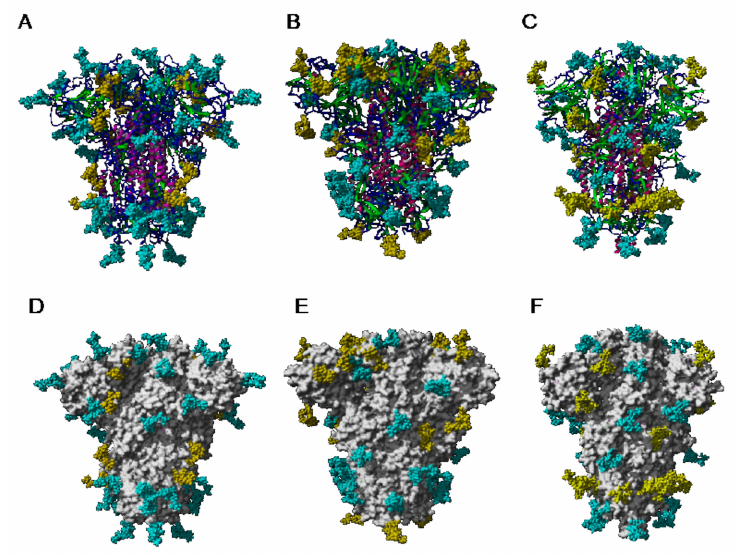
Figure 28. ( A – C ). Lateral face of the ribbon diagram representing the homotrimeric spike of SARS-CoV (PDB code 6ACD) ( A ), MERS-CoV (PDB code 5W9H) ( B ), and SARS-CoV-2 (PDB code 6VXX) ( C ). High- mannose glycans and complex glycans are colored yellow and cyan, respectively. ( D – F ). Lateral face of the molecular surface (colored grey) of the S-glycoprotein of SARS-CoV ( D ), MERS-CoV ( E ), and SARS-CoV-2 ( F ). High-mannose glycans and complex glycans are colored yellow and cyan, respectively.